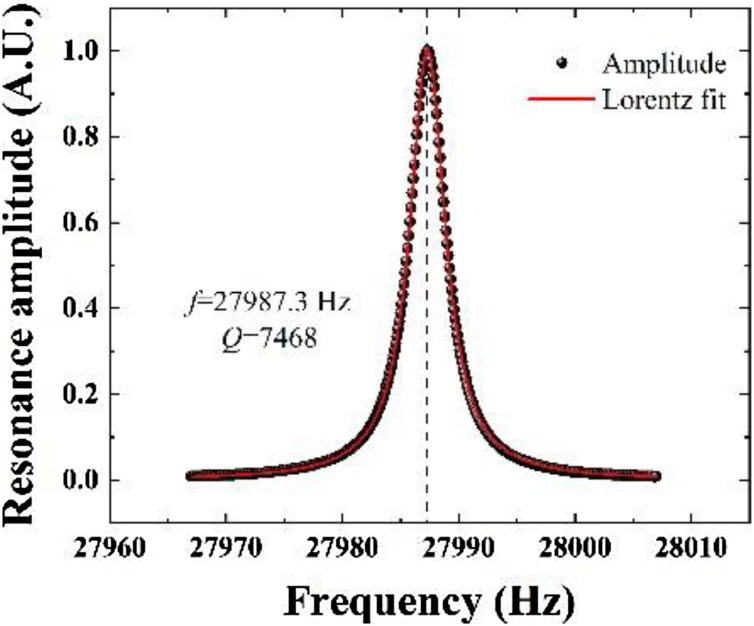
Resonance curve of the custom 28 kHz QTF. Lorentz function is used to fit the data and calculate the frequency and Q factor.